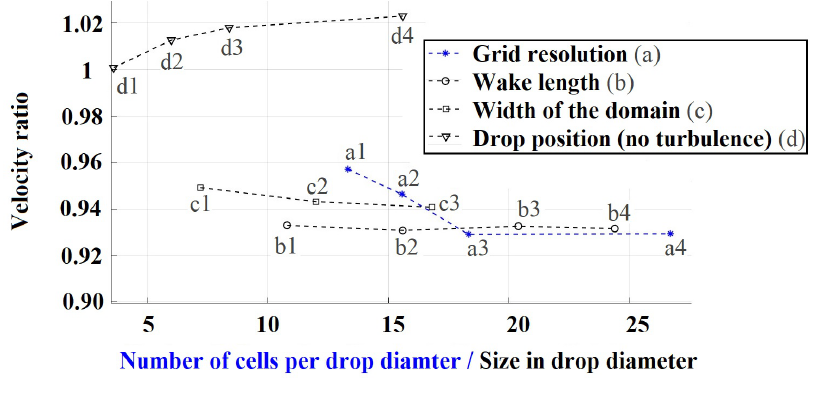
Figure A1. Studies of the grid resolution, the domain width and wake length, as well as the position of water drop in the stream-wise